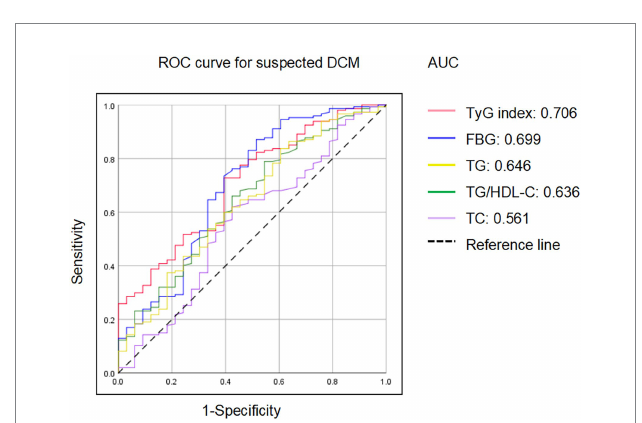
FIGURE 2 ROC analysis for the identification of diabetic patients with risk of HFpEF. TyG, triglyceride-glucose; FBG, fasting blood glucose; TG, triglycerides; HDL-C, high-density lipoprotein cholesterol; TC, total